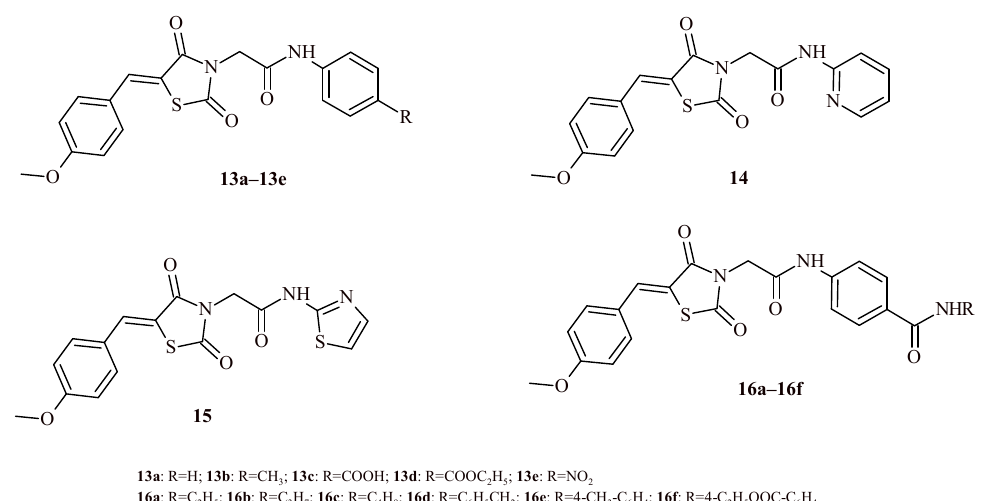
Figure 8. The 5-(4-Methoxybenzylidene)thiazolidin-2,4-dione Derivatives 13a – 13e , 14 , 15 and 16a – 16f with inhibitory effect on VEGFR-2. with inhibitory effect on